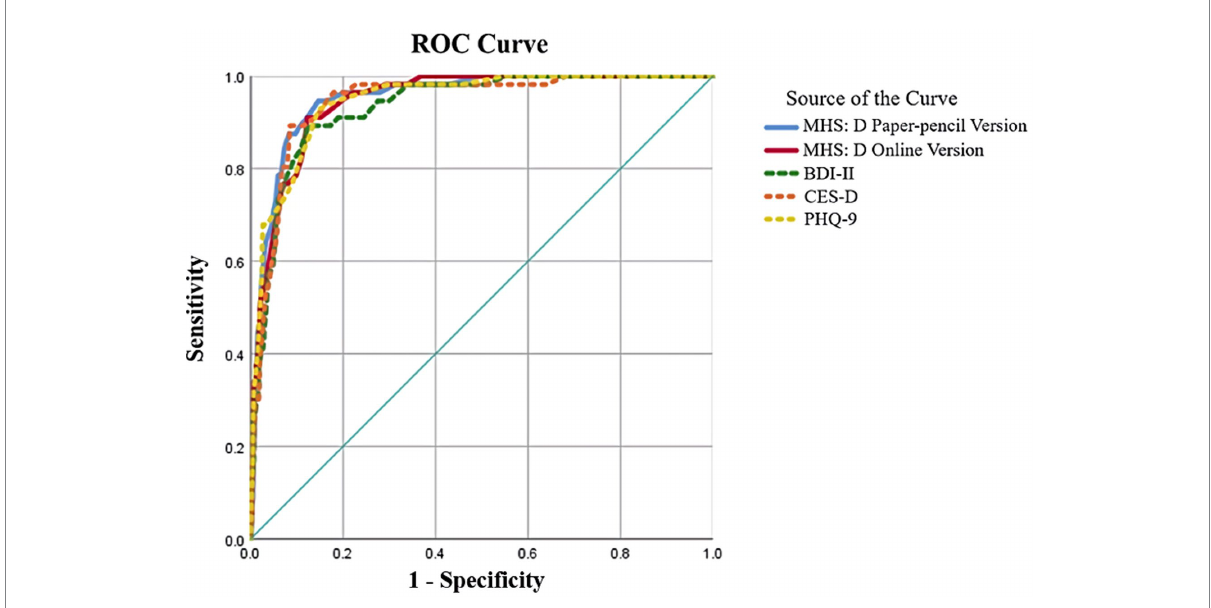
FIGURE 2 ROC curve for MHS:D and existing depression